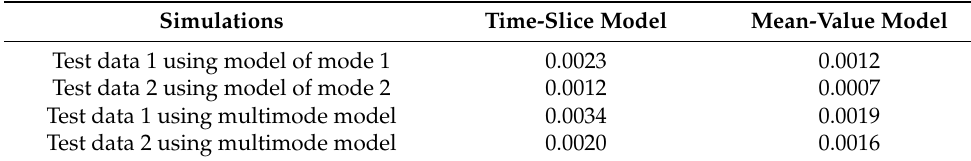
Table 2. RMSE values obtained by using the time-slice PLS and mean-value PLS models.